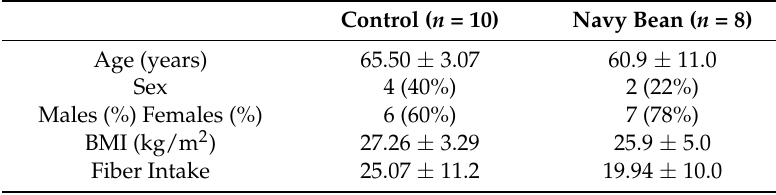
Table 1. Baseline characteristics of study